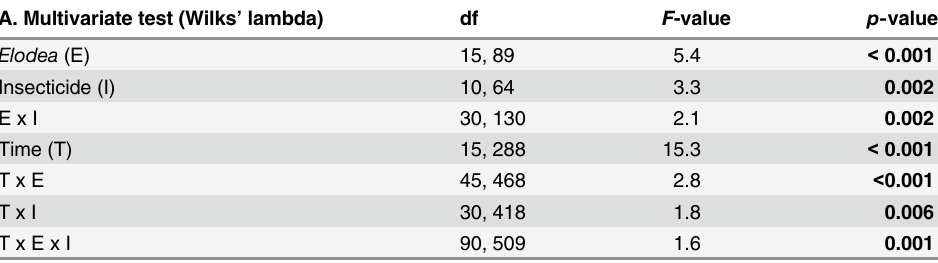
Table 1. Results of a repeated-measures MANOVA examining the multivariate effects of time, macro- phyte treatment, malathion treatment, and their interactions on all biotic response variables. A. Multivariate test (Wilks ’ lambda) df F -value p- value Elodea (E) 15, 89 5.4 < 0.001 Insecticide (I) 10, 64 3.3 0.002 E x I 30, 130 2.1 0.002 Time (T) 15, 288 15.3 < 0.001 T x E 45, 468 2.8 < 0.001 T x I 30, 418 1.8 0.006 T x E x I 90, 509 1.6 0.001 Bold p-values are signi fi cant at α =